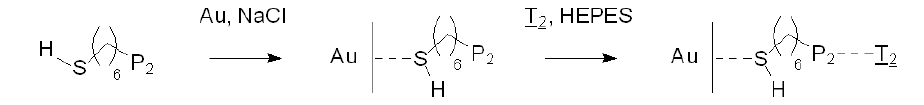
Figure 2. Thiol-labeled probe (P2) grafting and complementary target (T2) hybridization.